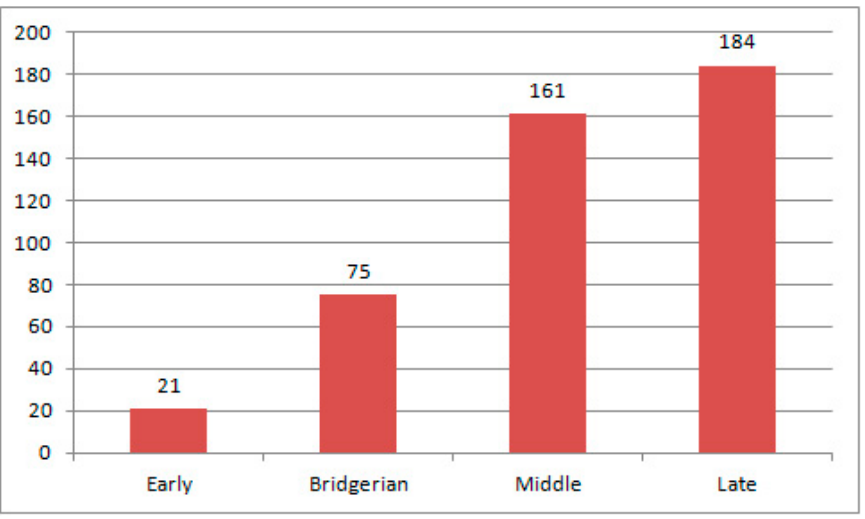
Figure 18. Change in the number of Curculionoidea species in the Eocene.